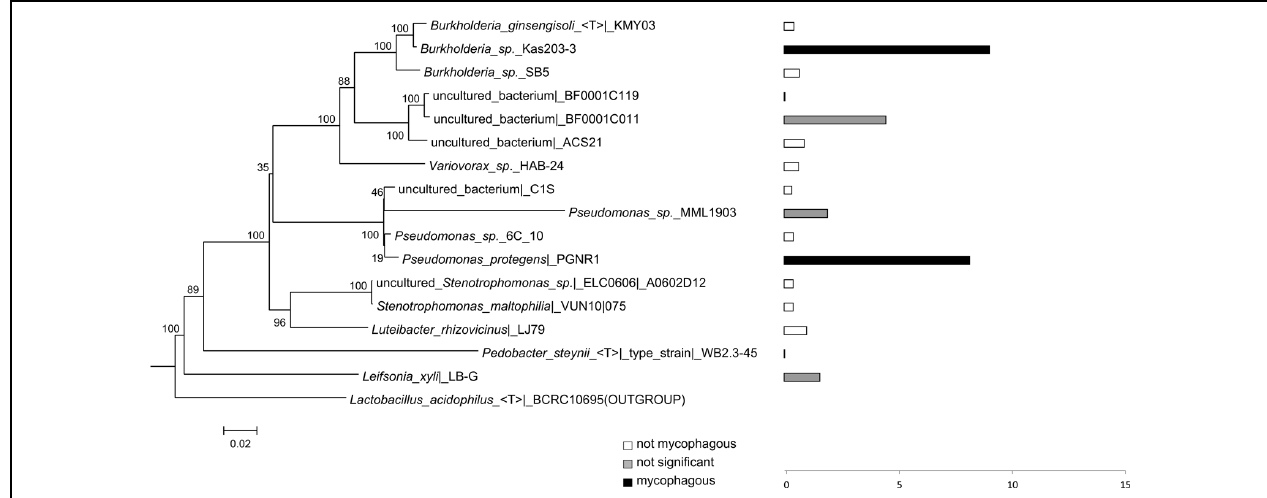
FIGURE 4 | Phylogeny and potential mycophagous ability of antifungal, hyphae-adhering bacteria retrieved with the short-term “liquid hyphal-baiting” approach, associated with R. solani . The indicated bacterial strains are cultured or uncultured bacteria that have the closest match of 16S rDNA sequences to one or several of the antifungal, hyphae-adhering bacterial isolates. Bars indicate measured mycophagy ratios. Black bars show bacteria with significant mycophagous growth (ratio > 1; P < 0.05), grey bars represent bacteria with possible mycophagous growth (ratio > 1; P > 0.05), and white bars indicate bacteria with no mycophagous growth (ratio ≤ 1). TABLE 2 | Mycophagous feeding patterns (mycophagy ratios per tested fungus) of antifungal bacterial isolates that were found to colonize hyphae of different several species.